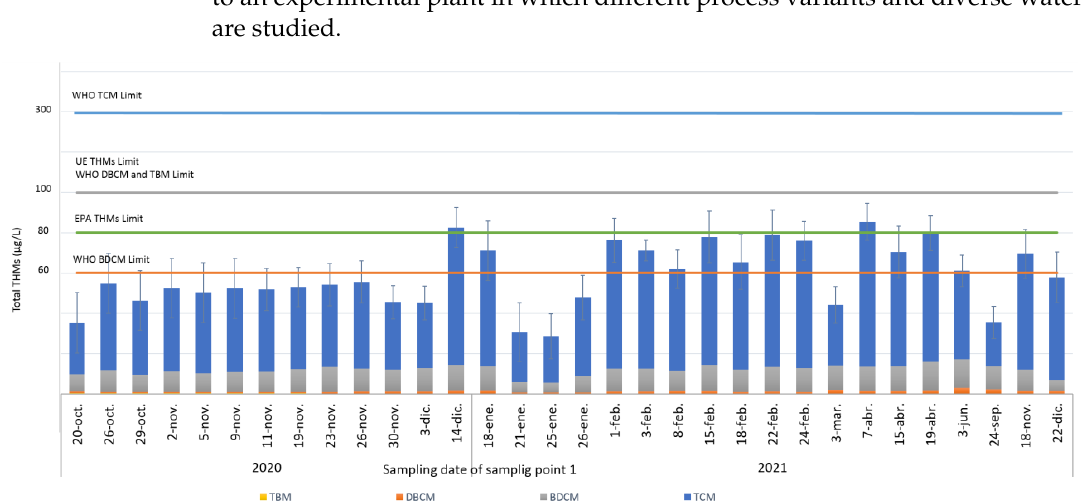
Figure 4. Total THMs concentration obtained in treated water samples (point 1 of Figure 1) from